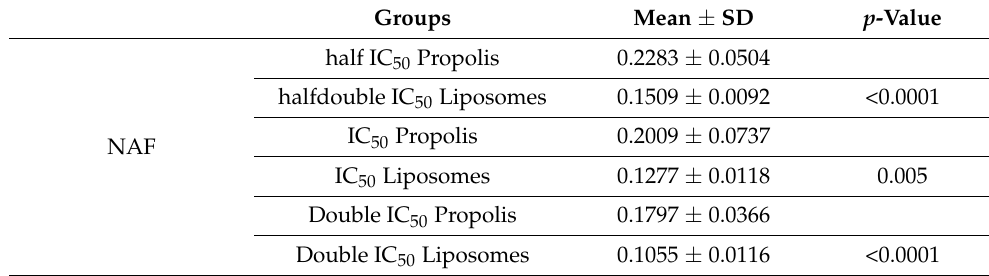
Table 11. Independent sample t -test to compare NAF between propolis and P-Lip at different con-